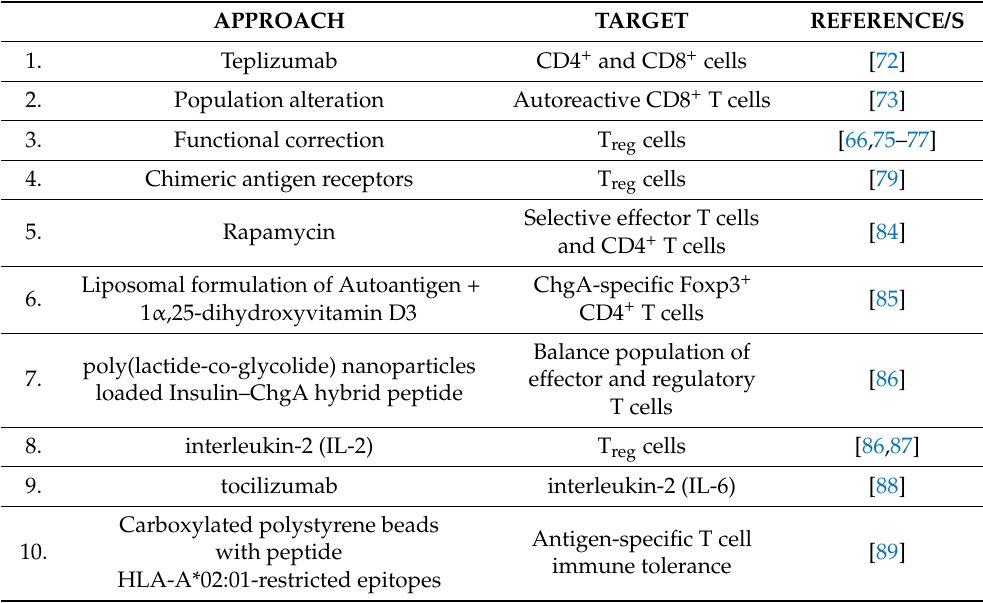
Table 1. Summary of strategies for targeting and regulating T cell population and function to- wards